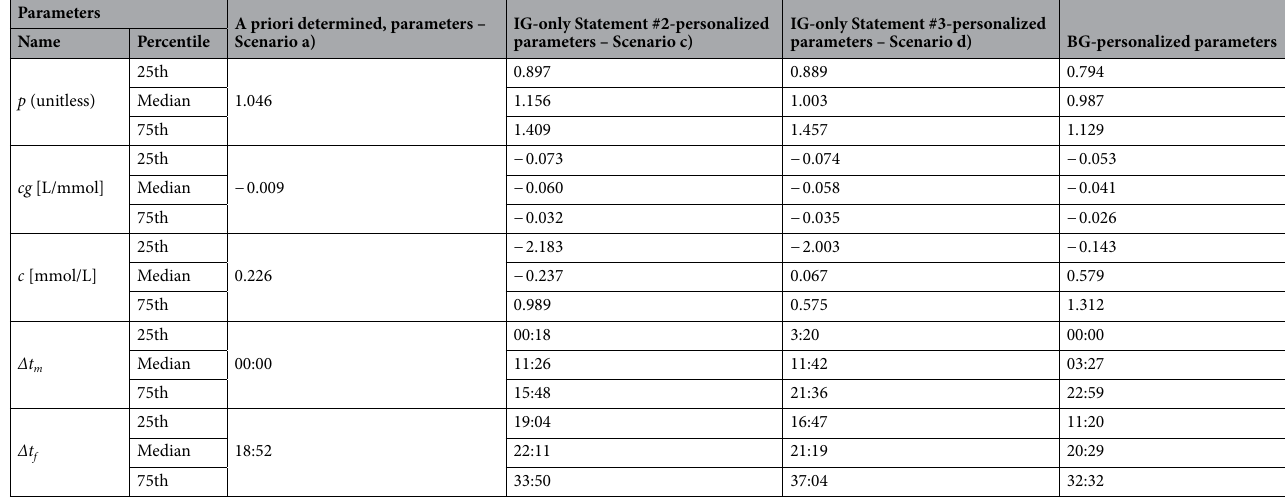
Table 1. Parameters of glucose-dynamics model with respect to Table 2. Median, 25th and 75th percentiles illustrate shape of the